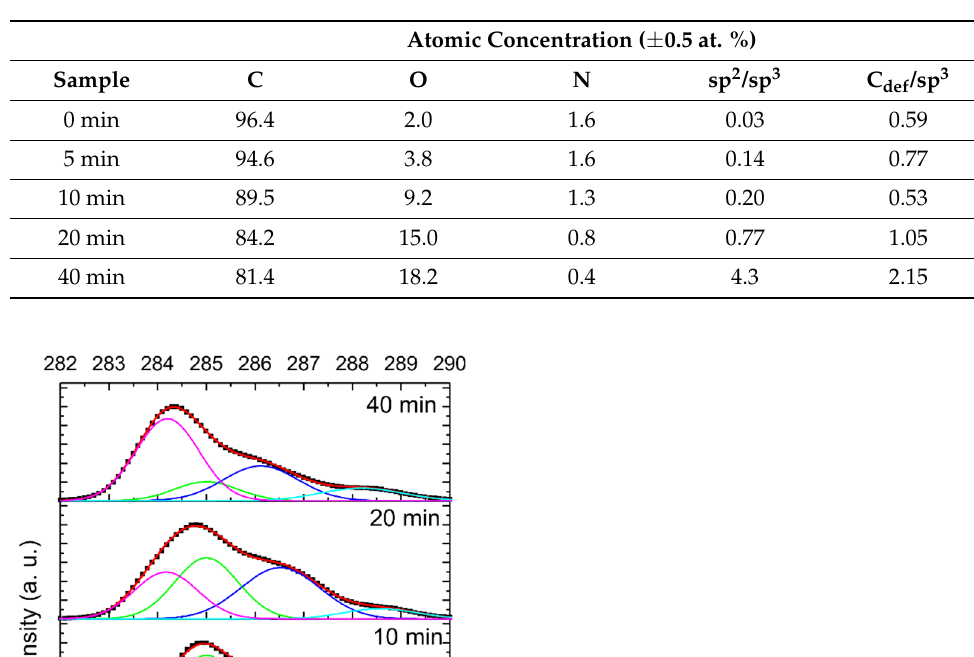
Table 1. Atomic composition, Csp 2 /Csp 3 , and C def /Csp 3 ratios of the samples as a function of laser irradiation time.